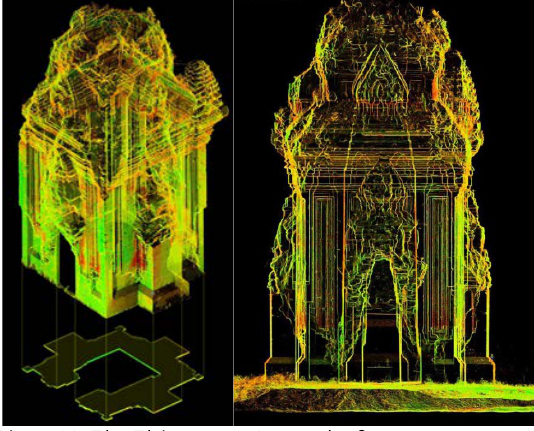
Figure 10. The sculpture of the God Shiva regarded as one of